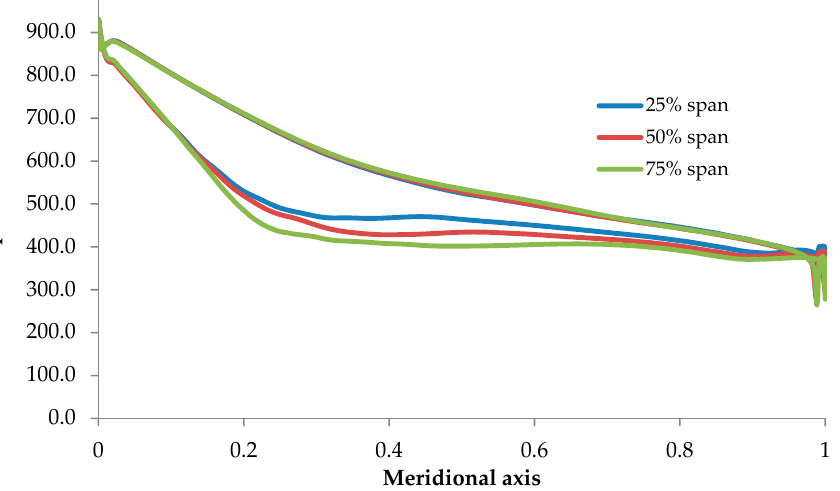
Figure 16. Pressure distribution along the rotor blade for R600a at three different locations: 25% span, 50% span, and 75% span.